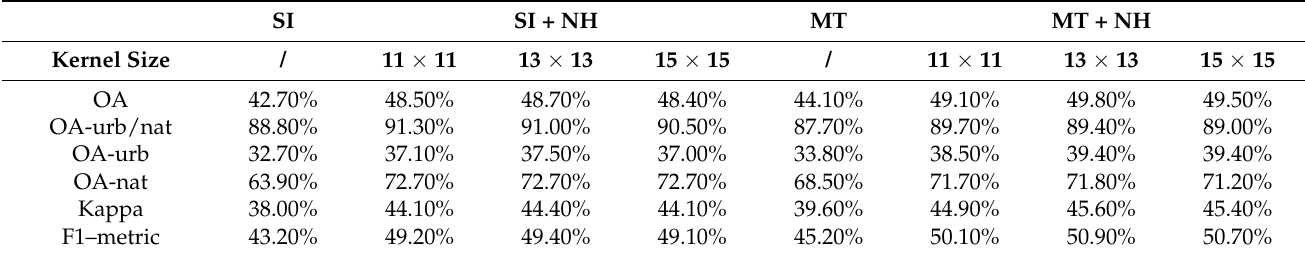
Table 4. Cape Town classification with 13 pixel neighborhood function.